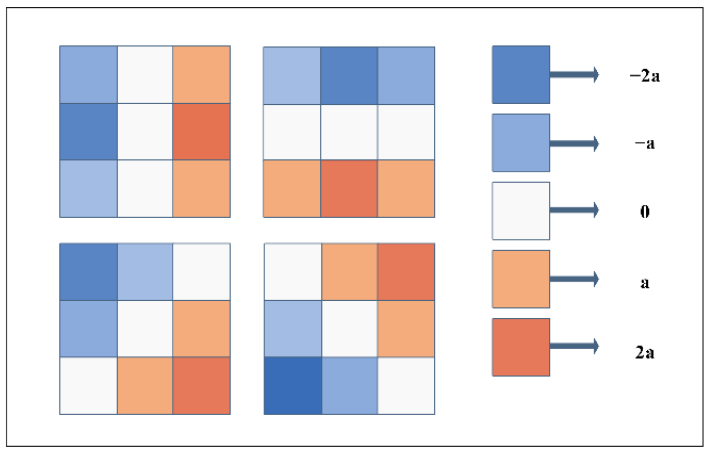
Figure 3. Schematic diagram of Sobel filter.